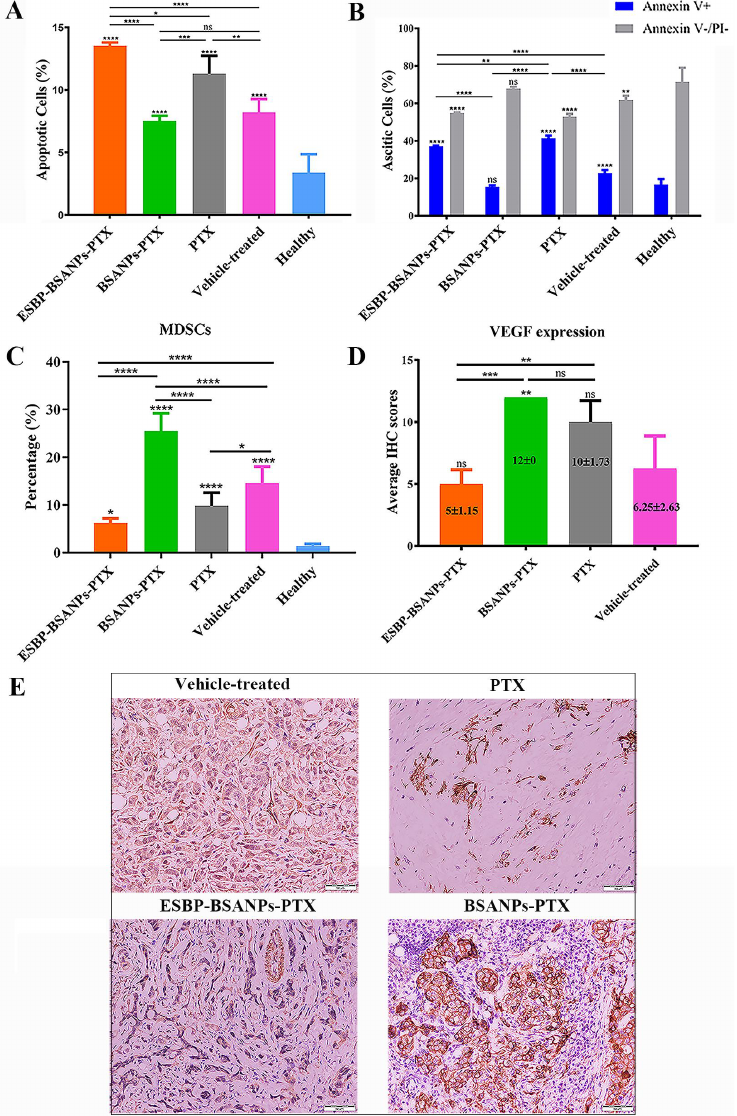
Figure 5. After four rounds of chemotherapy, the ( A ) apoptosis (PI-/Annexin V+) and ( B ) Annexin V+ staining of ascitic/peritoneal washing fluid cells in each treatment group were detected via